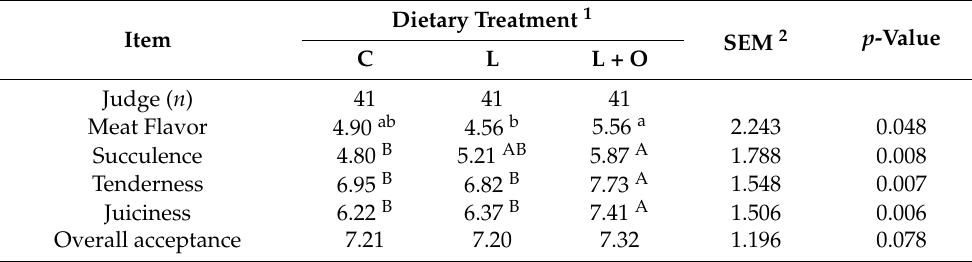
Table 10. Sensory analysis of meat from the Longissimus lumborum muscle